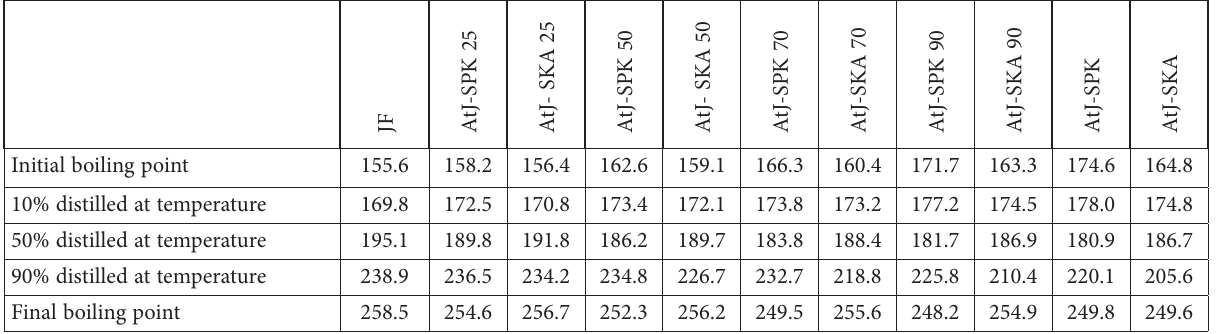
Table 5. Fractional composition of JF blends with AtJ-SPK and AtJ-SKA components (source: author development)